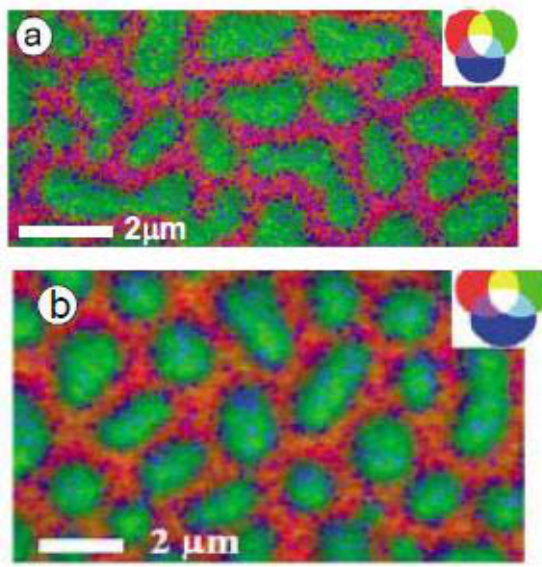
Figure 3 : Color coded rescaled component maps of 0.05 mg/mL Fg adsorbed to PS/PMMA from (a) buffer and (b) water. PS = red, PMMA = green, Fg = blue. [26] (reproduced with permission of the